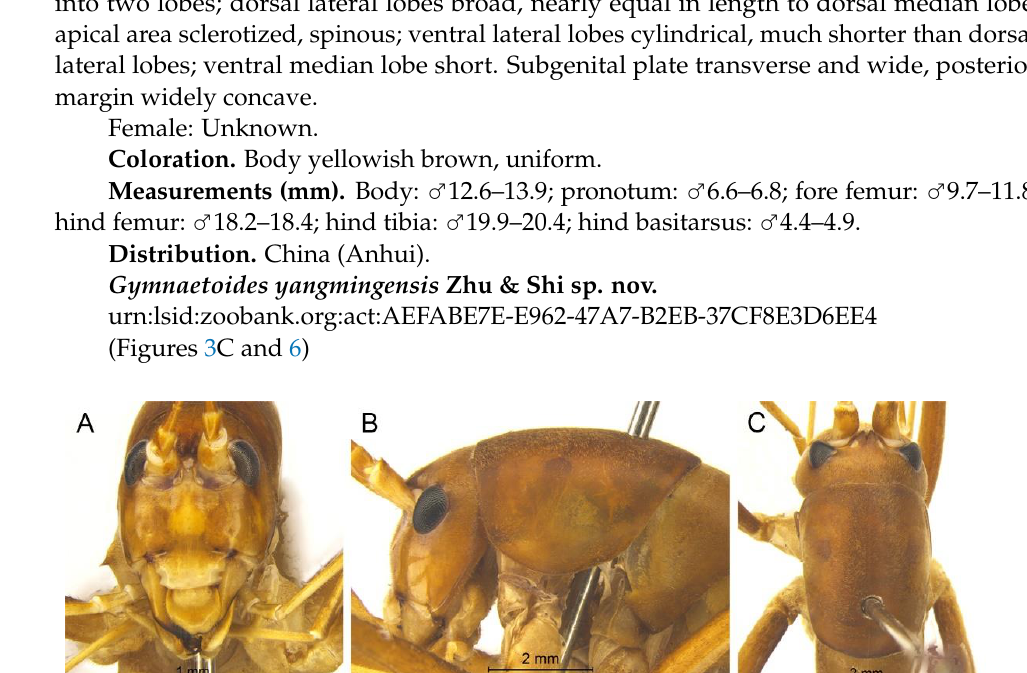
basitarsus with one dorsal apical spine.